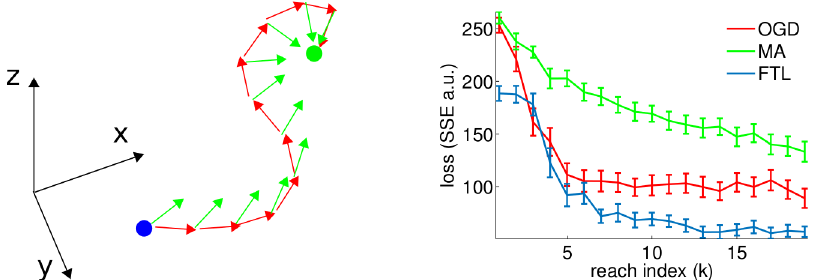
Fig 2. Left panel is a cartoon of the cursor task. The blue cursor is under user control and the user intends to move it towards the green target. On a given reach trajectory, the cursor is decoded according to the current decoder yielding the path made up of red arrows. At each state, the oracle intention is computed (green arrows) to be aggregated as part of D and incorporated into the update to the decoder. In the right panel, we compare the performance of the algorithms on a simulation of the cursor task (loss incurred during each trial k ). We use Alg 1 with the three update rules discussed (Alg. 1 and Table 1). Intuitively, OGD makes less ef fi cient use of the data and should be dominated by FTL. Moreover OGD has additional parameters corresponding to learning rate which were tuned by hand. MA performs least well, though we selected λ to be suf fi ciently close to 1 as to permit performance to gradually improve (smaller lambda leads to more unstable learning). Each update index corresponds to the inclusion of 1 additional reach. The entire learning procedure is simulated 100 times for each algorithm and errorbars are 2 standard errors across the